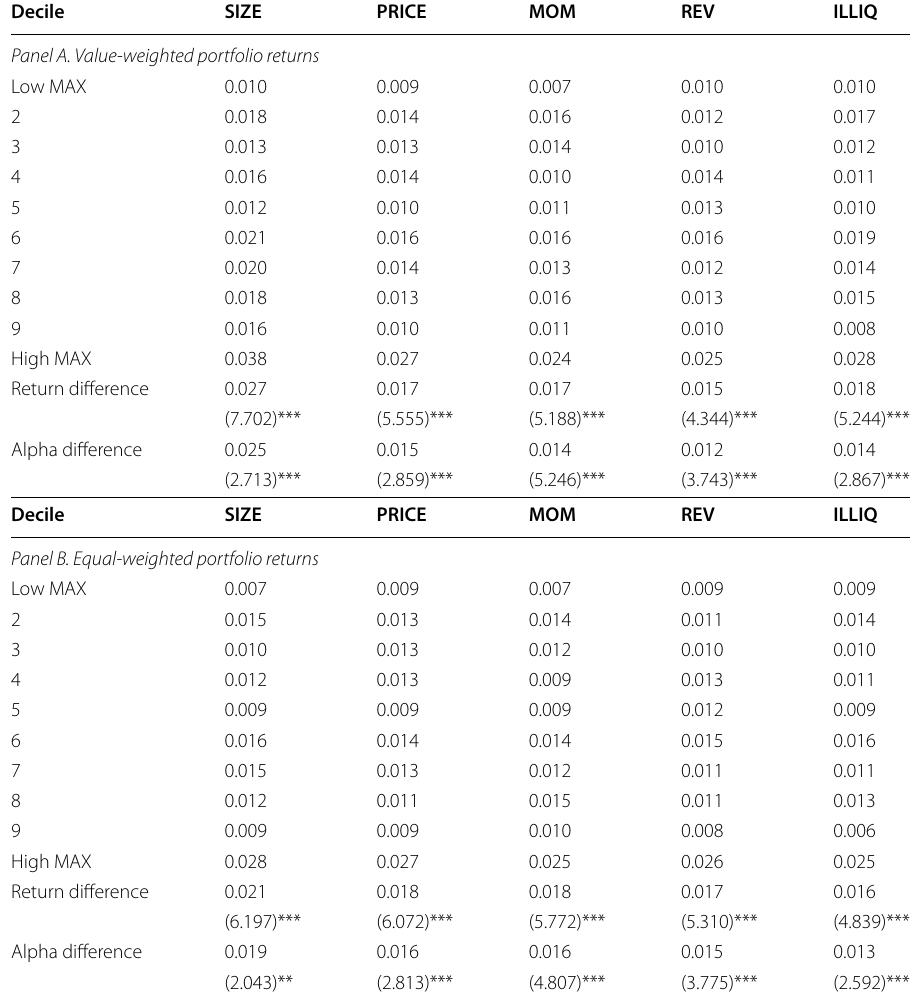
Table 7 Returns on portfolios of cryptocurrencies sorted by MAX after controlling for SIZE, PRICE, MOM, REV, and